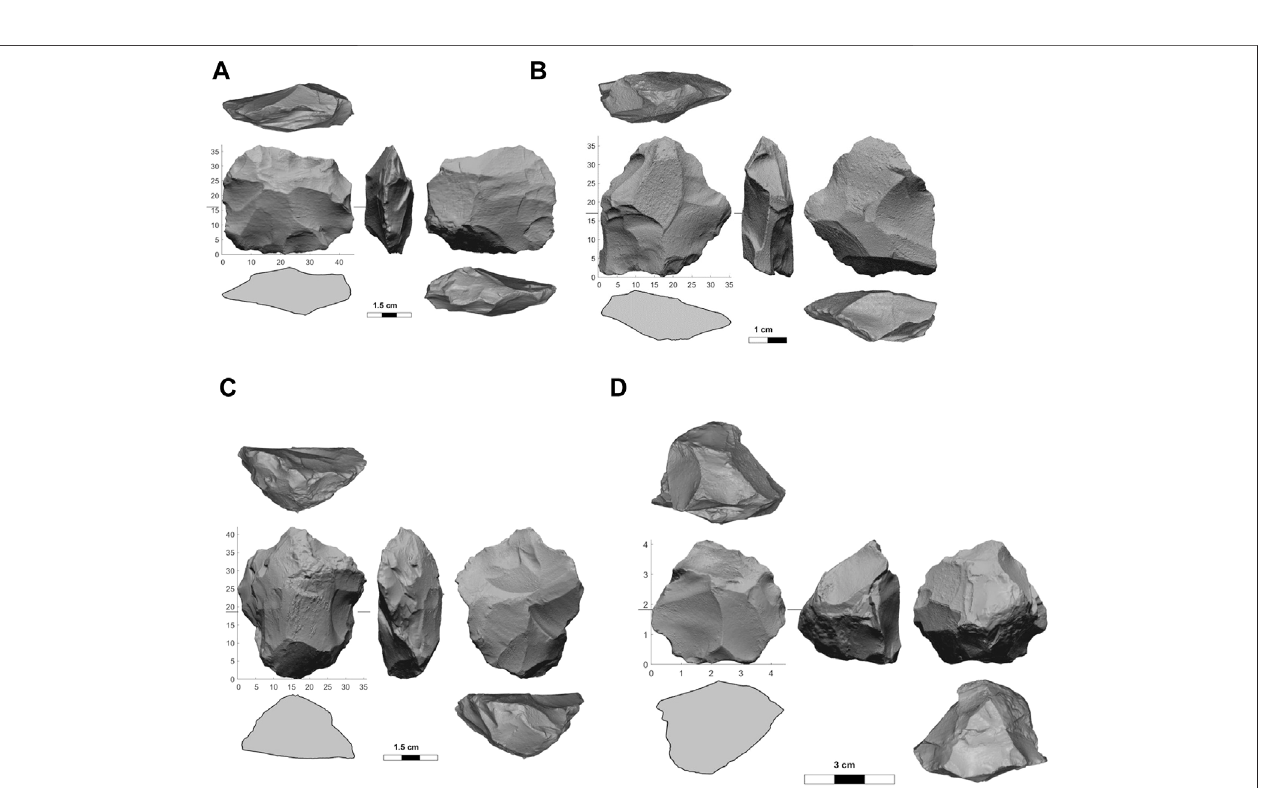
FIGURE 6 | (A – D) Prepared cores (general) from